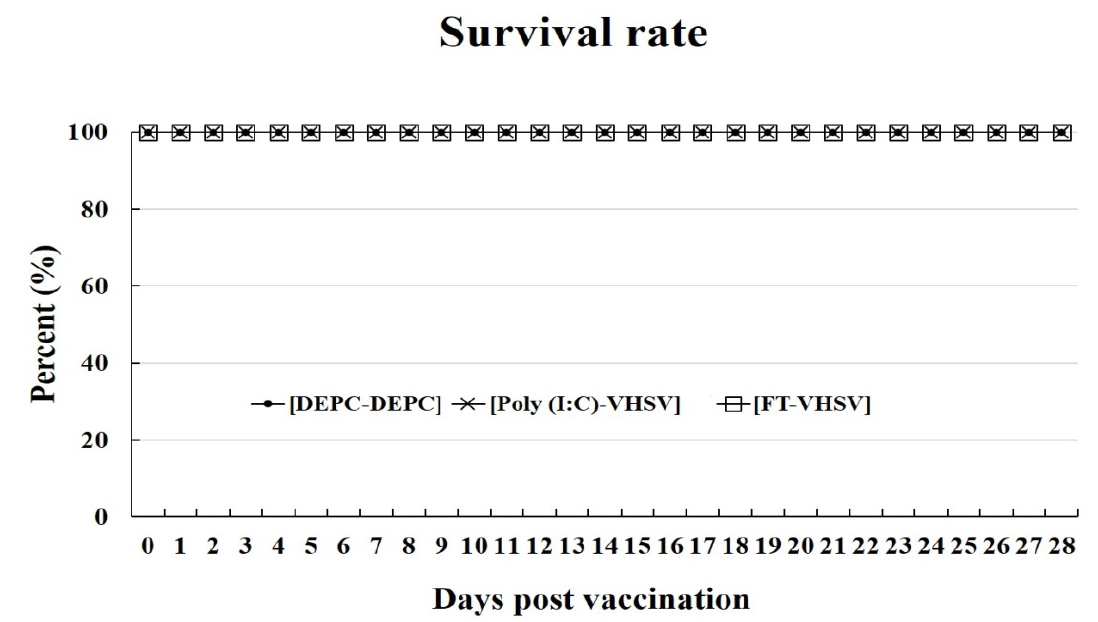
Figure 5. The level of survival in olive flounder after vaccination. Both Poly (I:C)-VHSV ( n = 30) and FT-VHSV ( n = 30) groups showed 100% survival after vaccination.